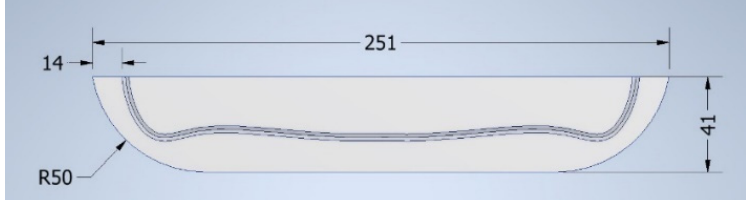
Figure 26. The model no. 2.